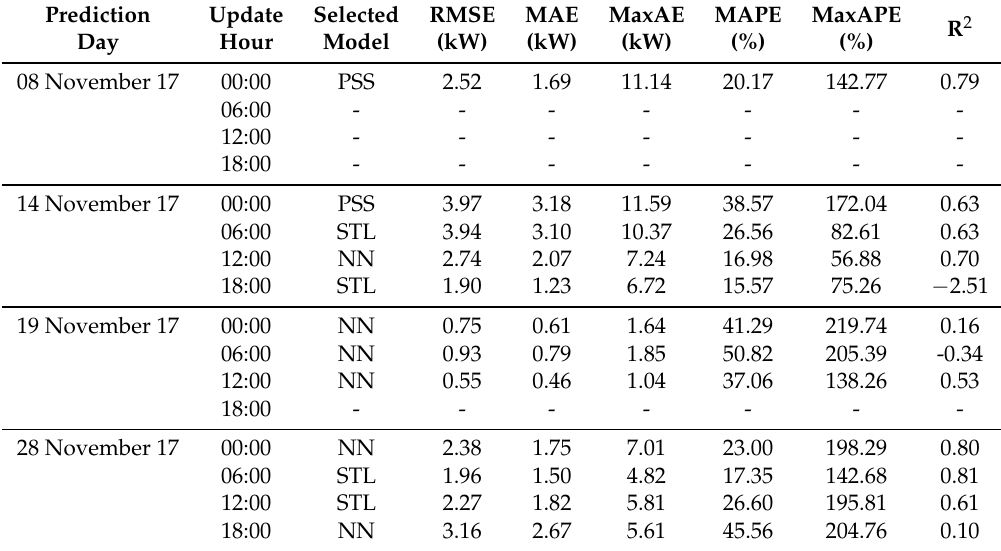
Table 5. Pilot systems: School (Palo del Colle). Computational Results. (UpdFreq = 6 h).